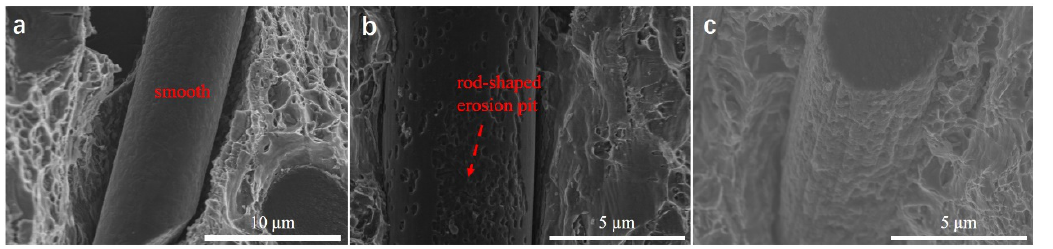
Figure 13. Morphologies fracture surface of SCFs/2024 Al about surface morphology of carbon fiber.